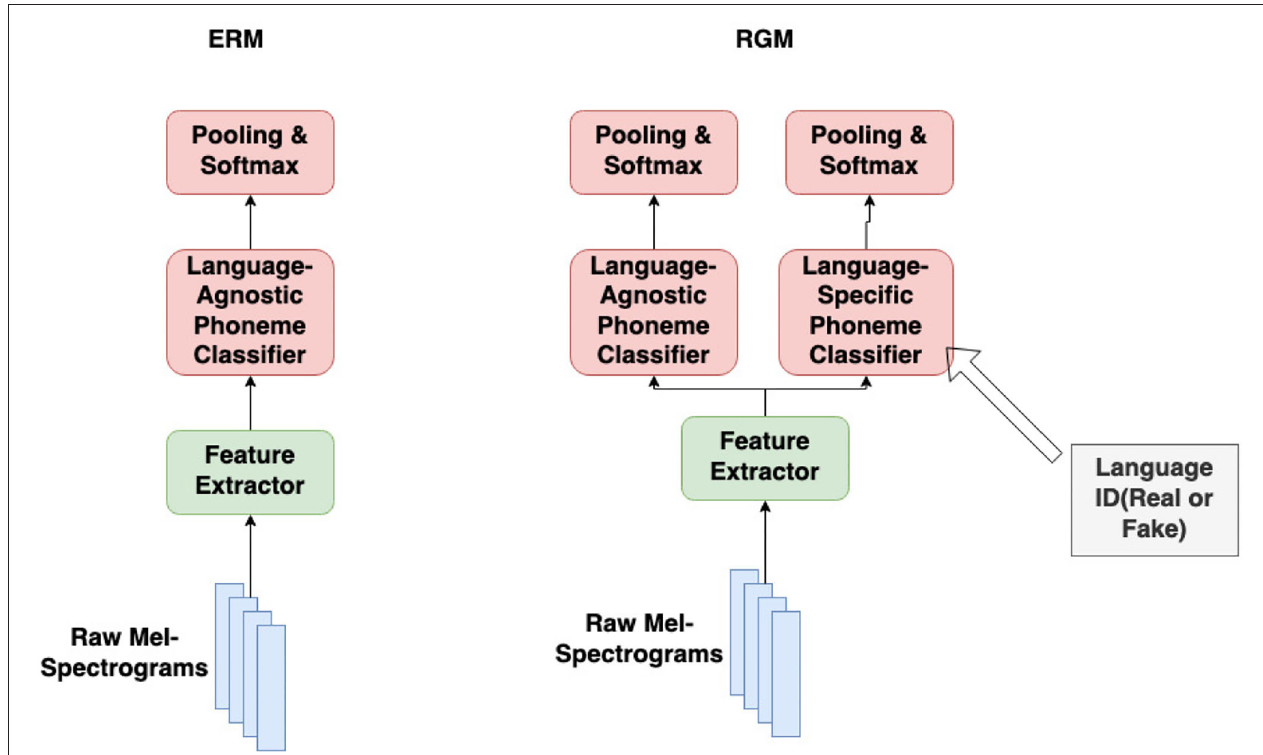
FIGURE 3 | The modified architecture for regret minimization (RGM) vs. the original architecture for empirical risk minimization (ERM). Both methods train a language-agnostic phone token classifier; RGM also trains language-specific phone token